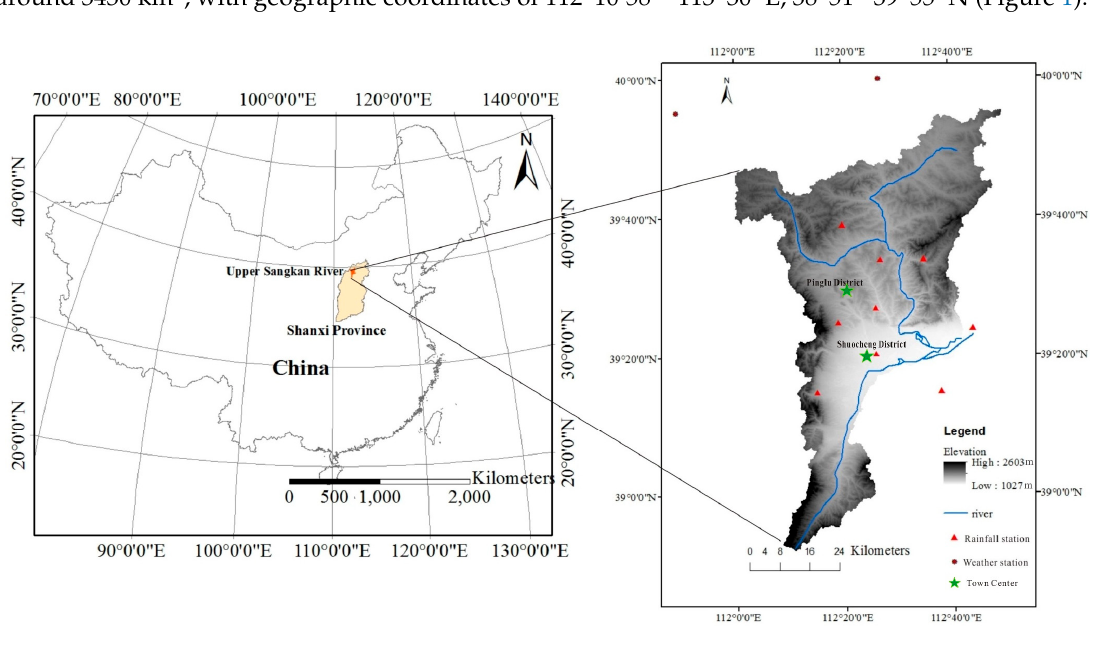
Figure 1. The location of the upper Sang-kan (USK) River basin and its Digital Elevation Model [35]. The length of the USK River is around 124 km. The northeast-southwest alignment of mountains structures the terrain. The terrain characteristics of this region are complex and the geomorphology is diverse. Elevation of this basin ranges from 1027 m at the watershed outlet to 2602 m in the hilly